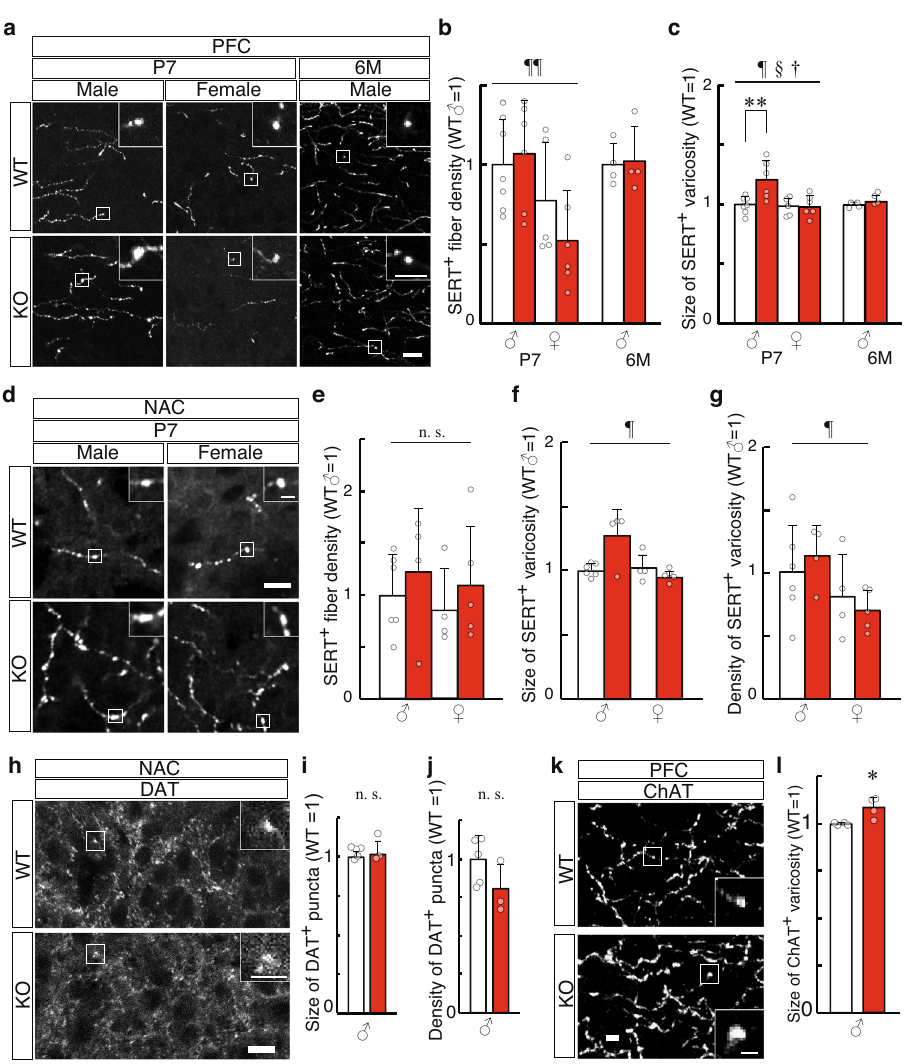
Fig. 3 Phenotypes of serotonergic, dopaminergic, and cholinergic fi bers in developing Slitrk1-KO mice. a – g Serotonergic fi ber in the PFC ( a – c ) and NAC ( d – g ) were analyzed by anti-SERT immunostaining. a Images of the PFC in 7 days-old (P7) or 6 months-old (6M) WT (P7 male, n = 7; P7 female, n = 5; 6M male, n = 4) and KO (P7 male, n = 6; P7 female, n = 6; 6M male, n = 4) mice. Insets indicate the enlarged views of the varicosities in the boxed region. Density ( b ) and varicosity size ( c ) of SERT + fi bers were measured. d Images of the NAC in WT (male, n = 6; female, n = 4) and KO ( n = 4, male; n = 5, female) mice at P7. Density ( e ), varicosity size ( f ), and varicosity density ( g ) of SERT + fi bers were analyzed. h – j Dopaminergic fi bers in the NAC were analyzed at P7 by anti-DAT immunostaining. h Images of the NAC in WT Size ( i ) and density ( j ) of DAT + puncta were analyzed. WT, n = 5; KO, n = 3. k , l Cholinergic fi bers in the PFC were analyzed at 6M with anti-ChAT immunostaining. k Images of the PFC. l Size of ChAT + varicosities. * P < 0.05 in t - test, n = 4 per genotype. ( All graphs ) Open bar , WT; red bar , KO. The average of male WT mice was de fi ned as 1 at each stage. Absolute values of the male WT varicosity size in µ m 2 ; c (SERT, PFC) P7, 0.79; 6M, 0.60; f (SERT, NAC) 0.70; i (DAT) 0.48, l (ChAT) 0.60. Data were presented as mean ± SD. * P < 0.05; ** P < 0.01 in t -test. † P < 0.05 (genotype); ¶ P < 0.05; ¶¶ P < 0.01 (sex); § P < 0.05 (genotype × sex interaction) in two-way ANOVA (genotype and sex as main factors). Scale bars , 10; 5 µ m (insets in a , h , k ); 2 µ m (inset in d ). + 3.3%, P = 0.028) (Fig. 5a, c). The results suggested that noradrenergic fi ber overgrowth may have partly caused the other